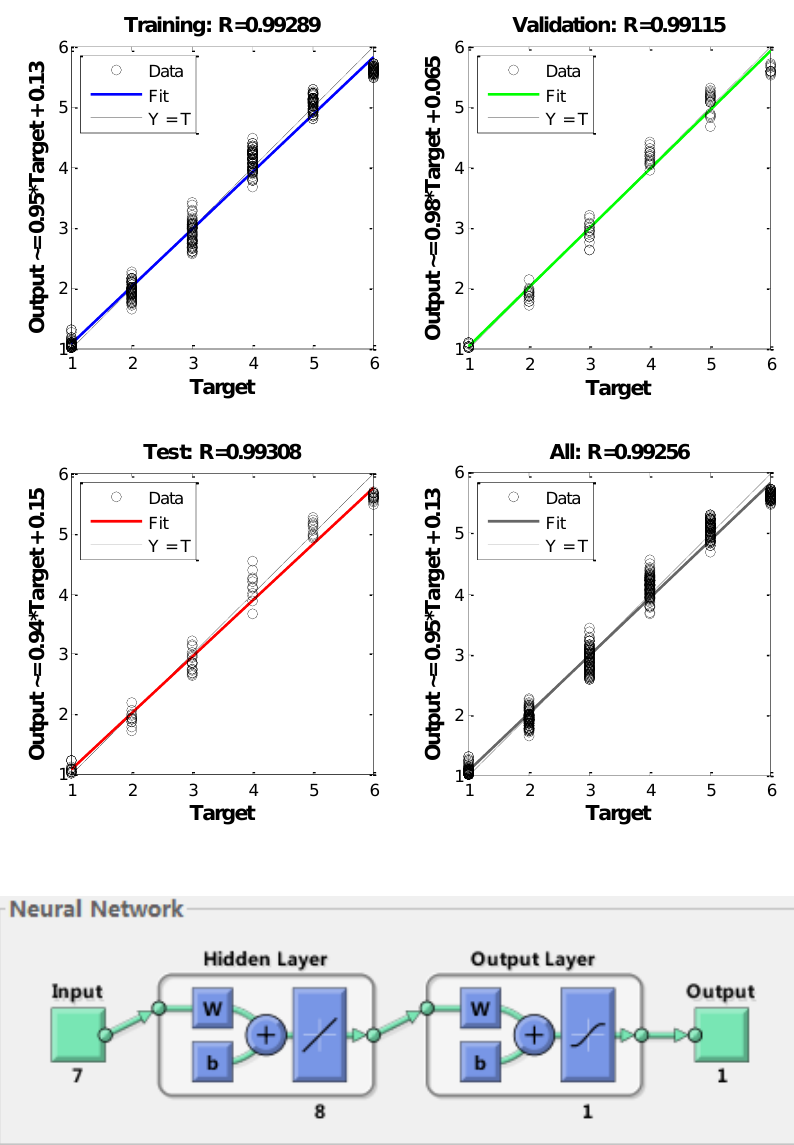
Figure 4. Structure of the back-propagation (BP) artificial neural network and training results.